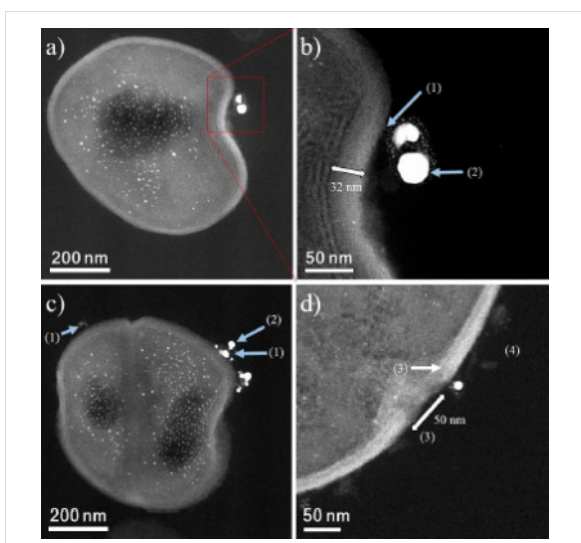
Figure 7: HAADF-STEM micrographs of MRSA cells. (a) MRSA cells surrounded by AgNPs, with AgNPs smaller than 10 nm also being found inside of the cells. (b,c) (1) CWGs. (2) AgNPs interacting with WTAs and CWGs. MRSA cell micrograph shows a cell wall size of 32 nm. The Ag nanoparticle concentration is 23 ppm. (d) (3) Mem- brane destabilization ( ≈ 50 nm).